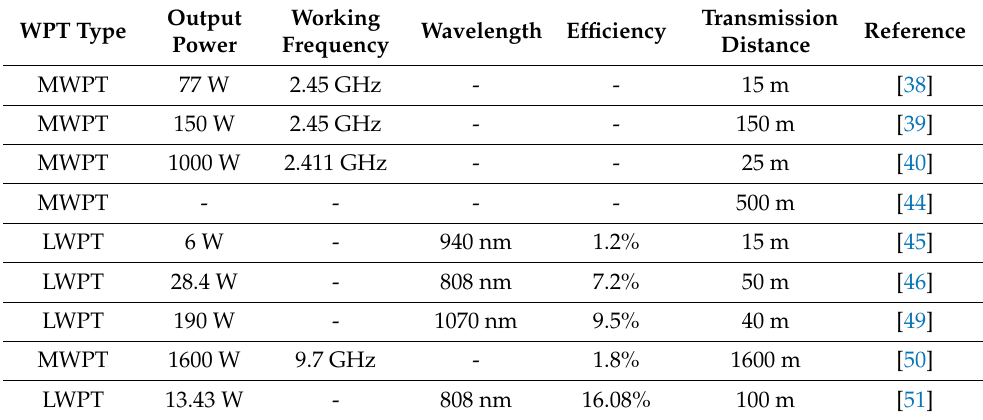
Table 2. Comparison of far-field WPT technologies used to power